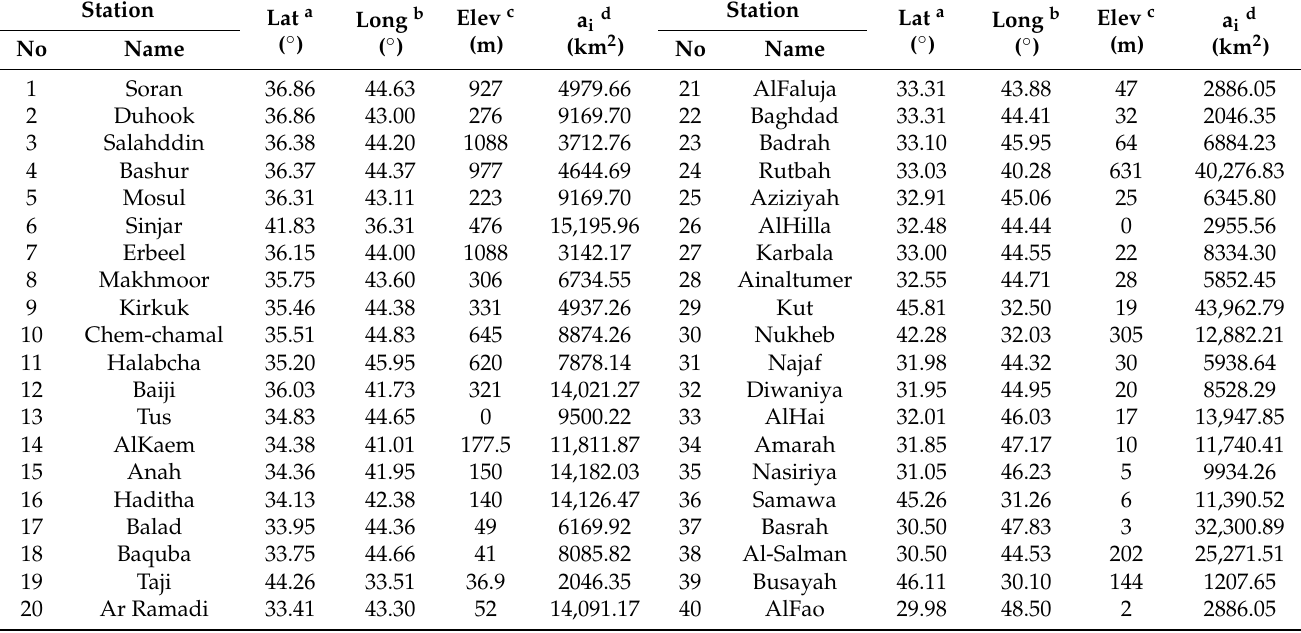
Table 1. Overview of the Iraqi weather stations with the corresponding area (km 2 ) that was computed based on the ArcGis 10.4 programming